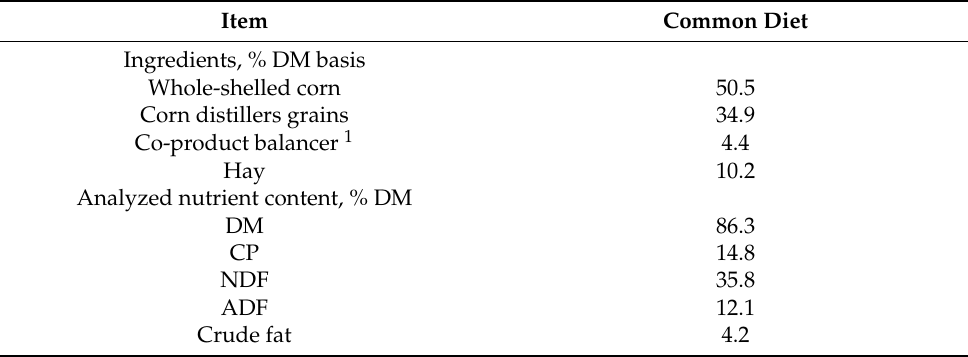
Table 3. Nutrient composition of the backgrounding diet for